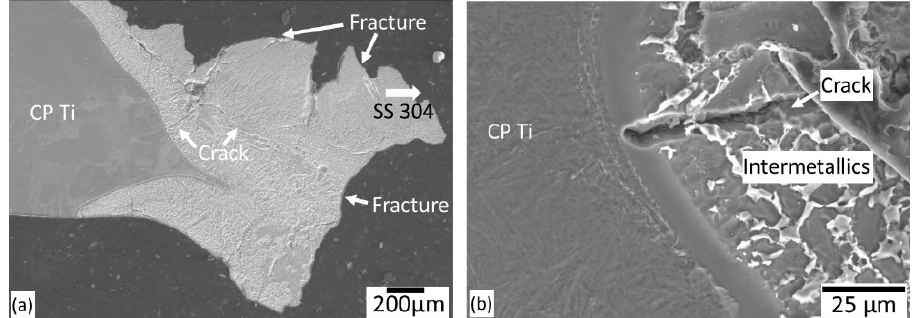
Figure 11. SEM images of GTAW showing ( a ) the fusion zone and fracture locations on the SS304 side, and ( b ) intermetallic compounds including a layer adjacent to the CPTi.